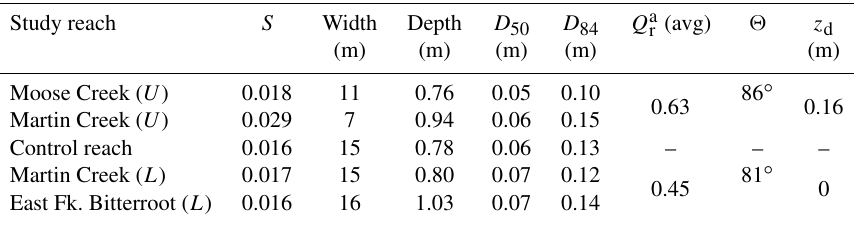
Table 1. Channel morphology and bed-material grain-size characteristics at each study reach. Width and depth values are bank-full dimen- sions, as measured along surveyed cross sections; Q r , θ , and z d are illustrated and defined in Fig. 1. Upper- and lower-confluence reaches are denoted by ( U ) and ( L ), respectively.